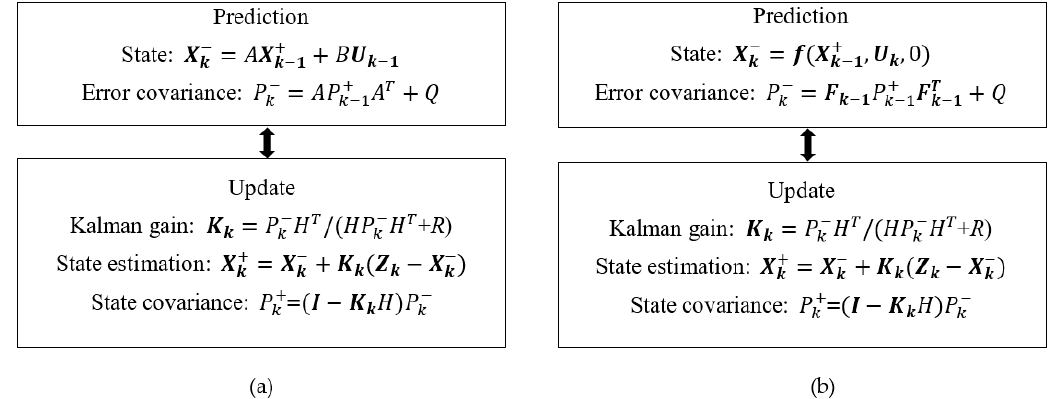
Figure 1. Kalman algorithm operation diagram. ( a ): Kalman and ( b ): extended Kalman.